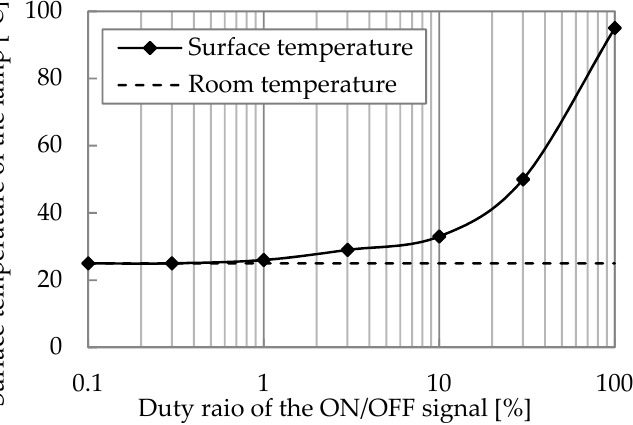
Figure 7. The dependence of the surface temperature of the excimer lamp on the duty ratio of the ON/OFF